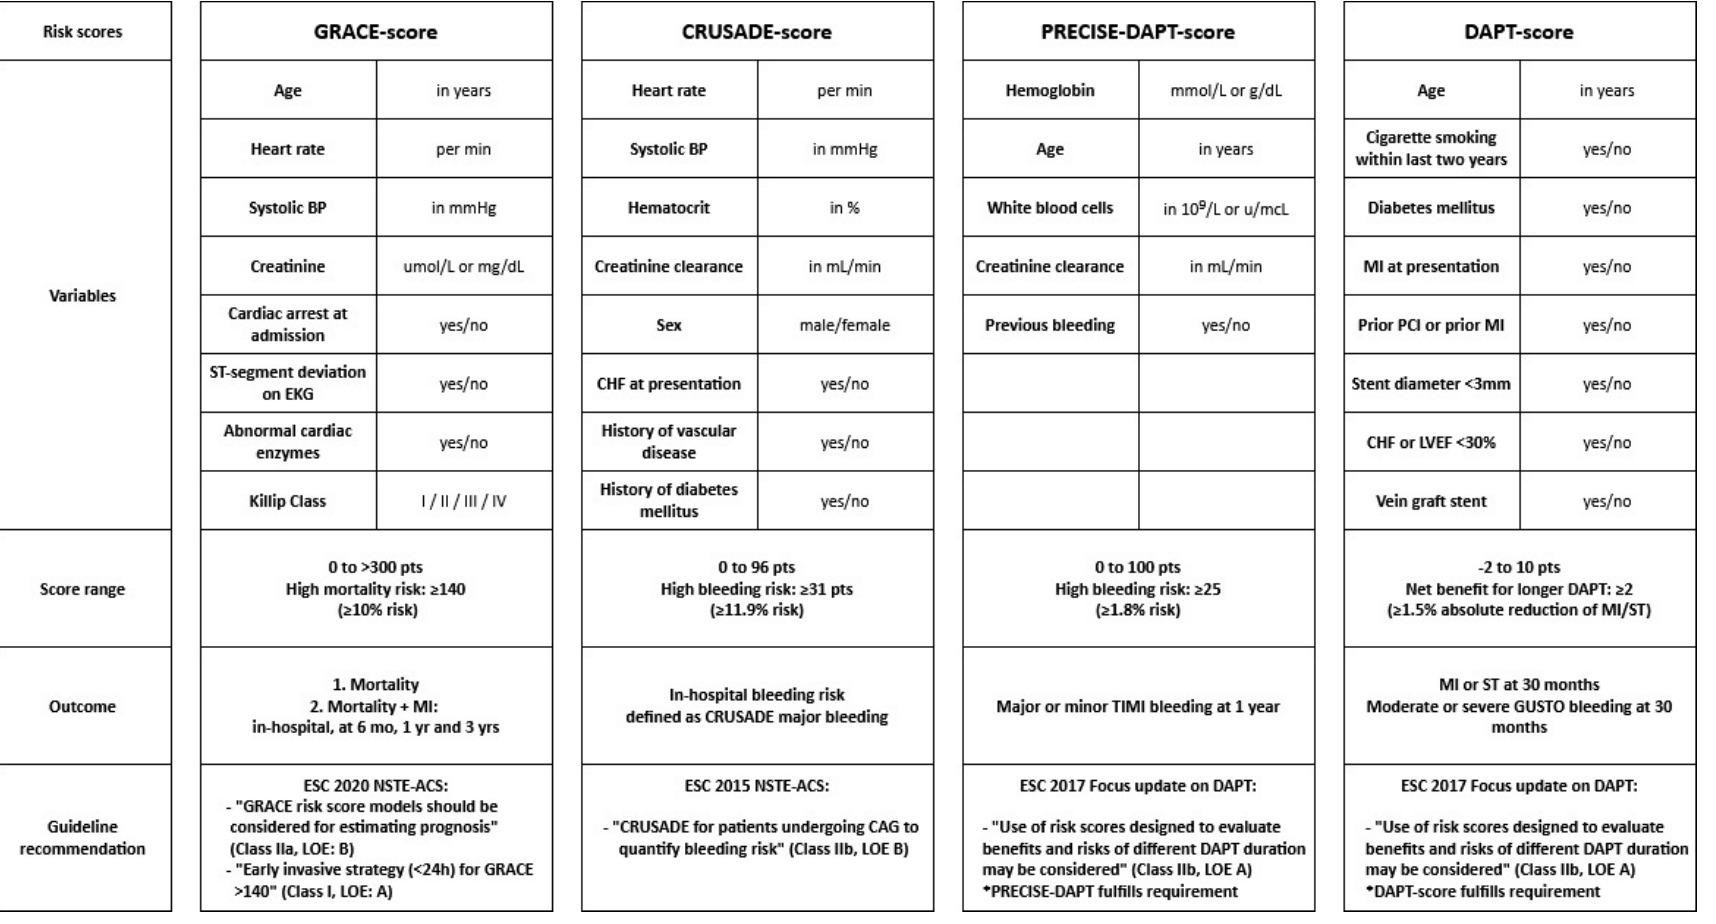
Figure 1. Risk scores endorsed by the guidelines of the European Society of Cardiology. Abbreviations: BP: blood pressure. CHF: congestive heart failure. DAPT: dual antiplatelet therapy. ESC: European Society of Cardiology. LVEF: left ventricular ejection fraction. LOE: level of evidence. MI: myocardial infarction. mo: months NSTE-ACS: non-ST elevation acute coronary syndrome. PCI: percutaneous coronary intervention. ST: stent thrombosis.